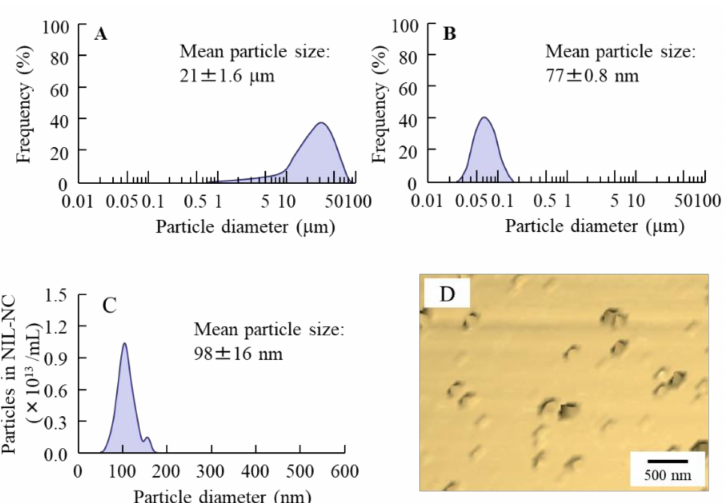
Figure 1. Size frequencies and AFM image of NIL particles treated with or without a bead mill. ( A , B ): particle size frequencies of NIL-MP ( A ) and NIL-NP ( B ) dispersions obtained by the SALD- 7100. ( C ) particle size frequencies of NIL-NP dispersions obtained by the NANOSIGHT LM10. ( D ): AFM image of NIL-NP dispersions obtained by the SPM-9700. The bar shows 500 nm. The dispersions containing NIL-NPs were obtained by the bead mill treatment, and the size was approxi- mately 30–150